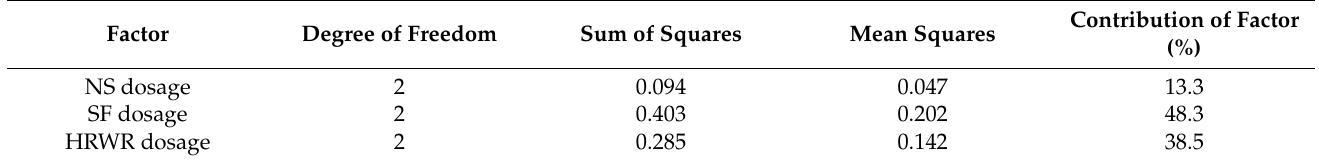
Table 9. Analyses of variance (ANOVA) for plastic viscosity.